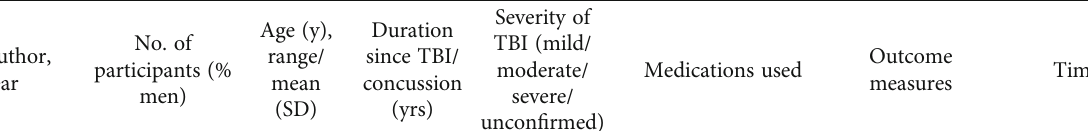
Table 1: Characteristics of included